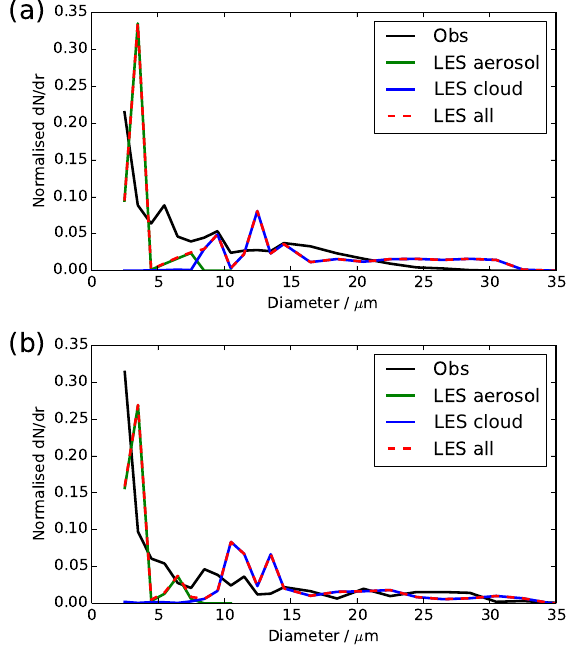
Figure 9. Cloud droplet size spectra at (a) 00:30UTC and (b) 03:30UTC, showing observations (black) and LES (red). For the LES, we also show the number of activated drops (blue) and number of aerosol particles